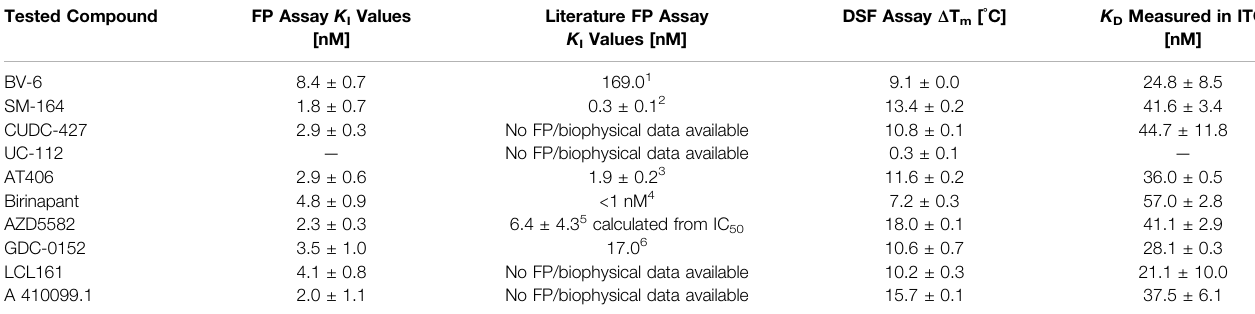
TABLE 1 | Results of the compound titrations using the fl uorescence polarization assay in comparison to published values from the literature, DSF and ITC measurements. Tested